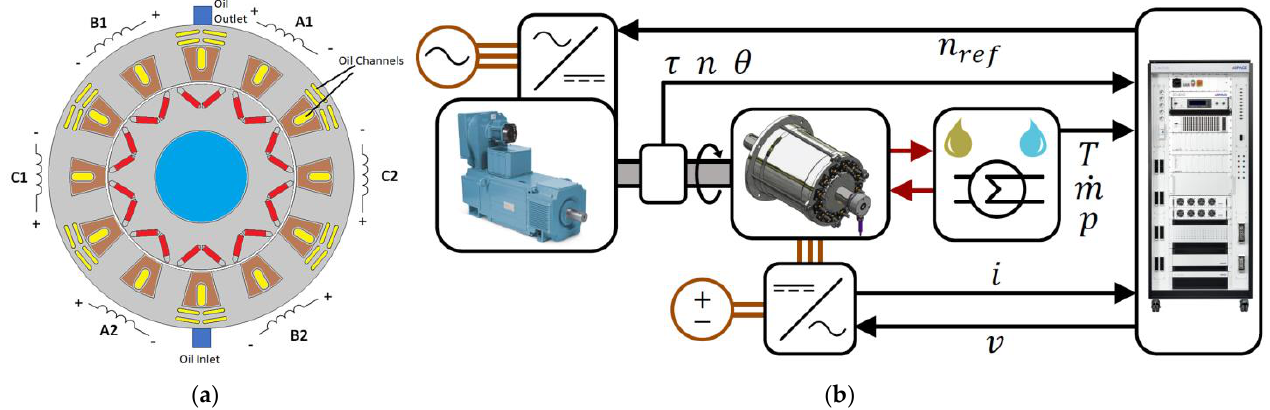
Figure 6. ( a ) Electrical machine design established and manufactured in [14] for direct oil cooling in the stator yoke and winding slot. ( b ) Calorimetric measurement system